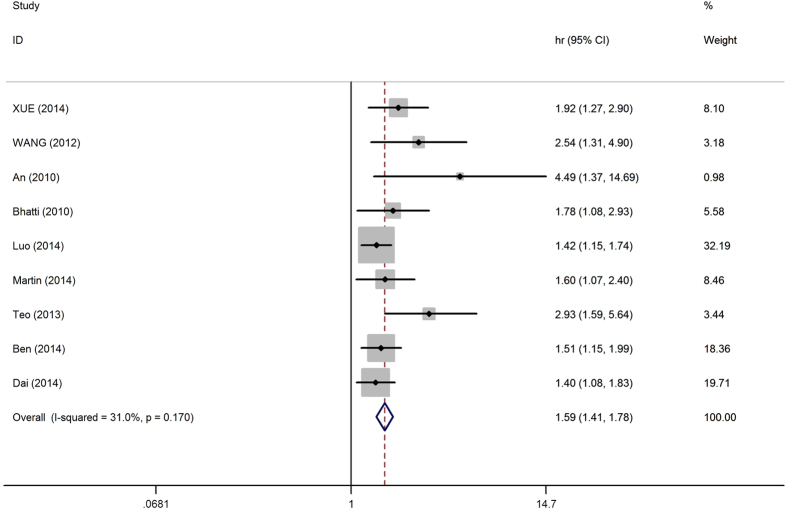
Forest plot of HR and 95%CI for each study.Fixed-effects pooled HR = 1.59, 95% CI = 1.41 − 1.78, P < 0.01; I2 = 31.0%, Pheterogeneity = 0.170.